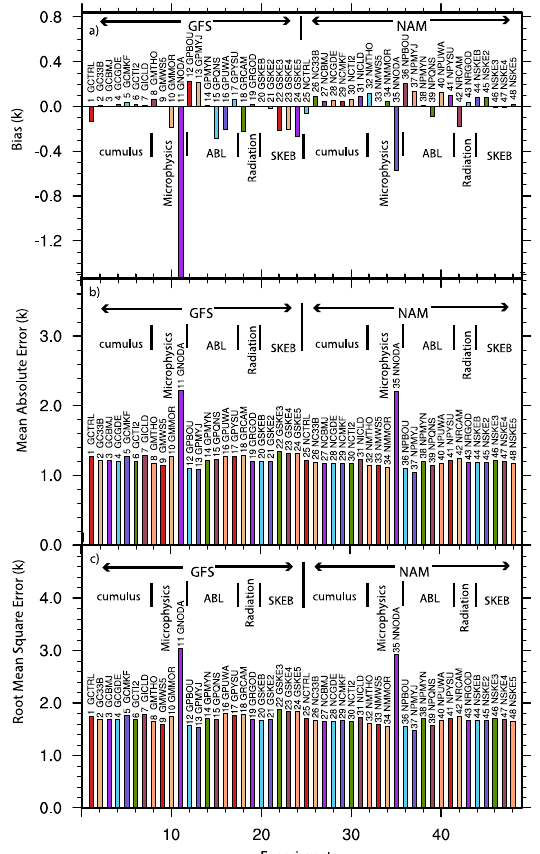
Figure 6. Averages on Domain 3 of ( a ) bias, ( b ) MAE and ( c ) RMSE in T2 from analyses during the one-week study period in January. The unit is K.